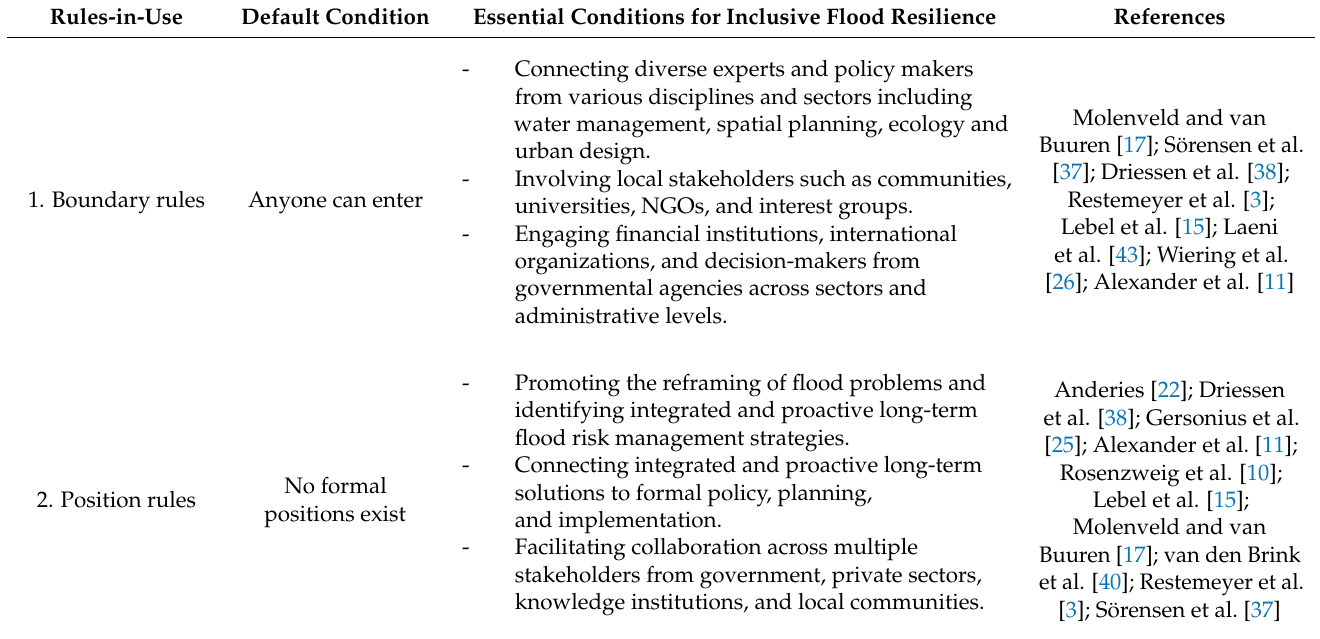
Table 1. Operationalizing rules-in-use for the institutional analysis of inclusive flood resilience planning.